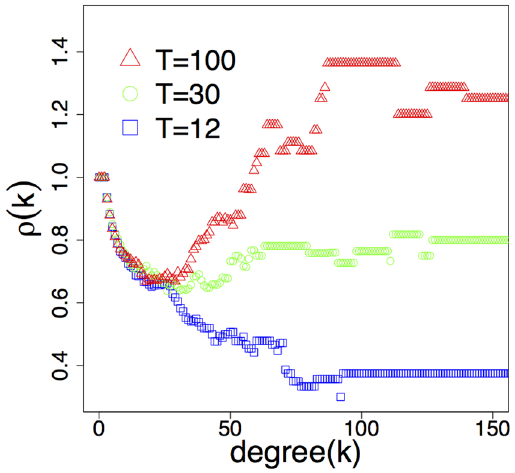
Figure 6. Rich-club organization in networks generated by the model with different settings of T . The plot readily confirms that our model is able to generate rich-club diversity by simply adjusting T . We note the remarkable similarity with the same plot for real networks in Fig. 1.